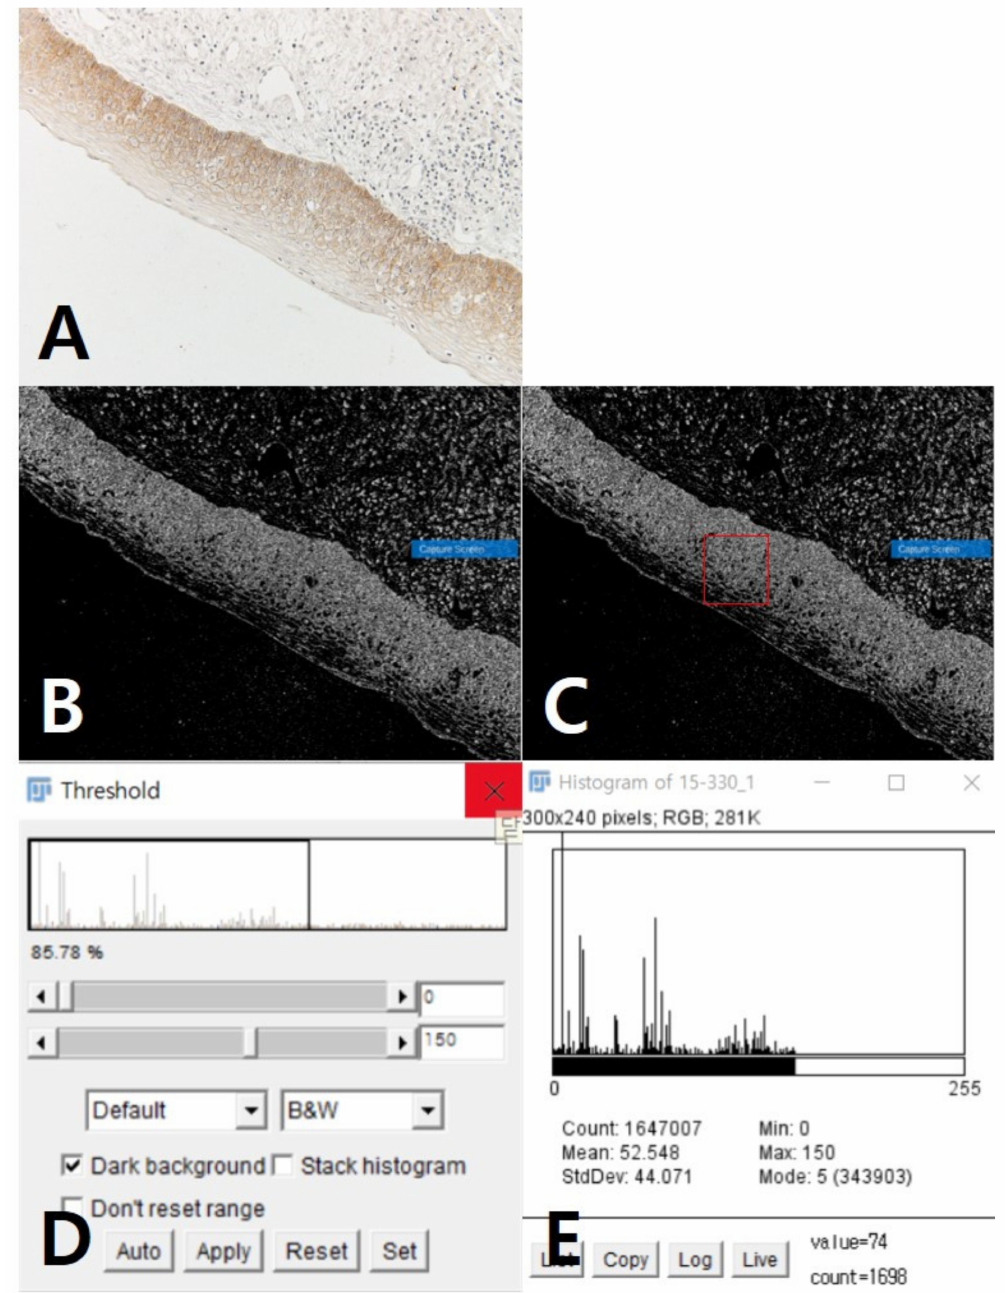
Figure 2. Measurement of immunohistochemistry (IHC) staining based on intensity: ( A ) original stained photo with red, green, and blue (RGB) adjusted to 8-bit color; ( B ) setting threshold; ( C ) measuring intensity within area; ( D ) threshold control window; ( E ) measured intensity in histogram